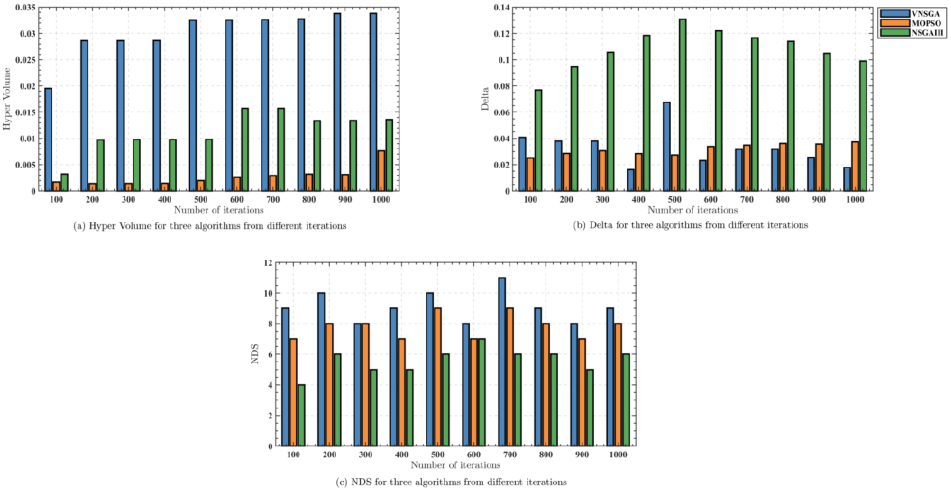
Figure 11. Hyper volume, Delta, and NDS for three algorithms from different iterations for 75 m R s max and 150 m R c max with respect to area A.